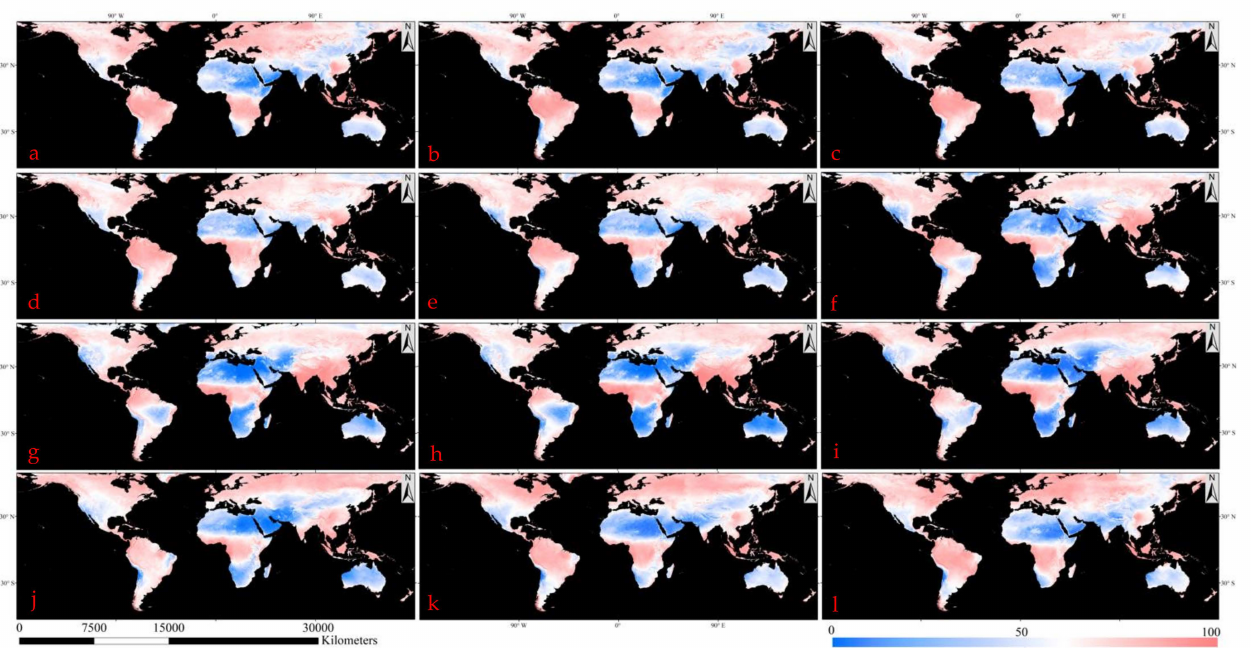
Figure 4. The 16-year ten-day average cloud frequency (%) for the 2nd ( a ), 5th ( b ), 8th ( c ), 11th ( d ), 14th ( e ), 17th ( f ), 20th ( g ), 23rd ( h ), 26th ( i ), 29th ( j ), 32nd ( k ), and 35th ( l ) ten-day period, respectively.